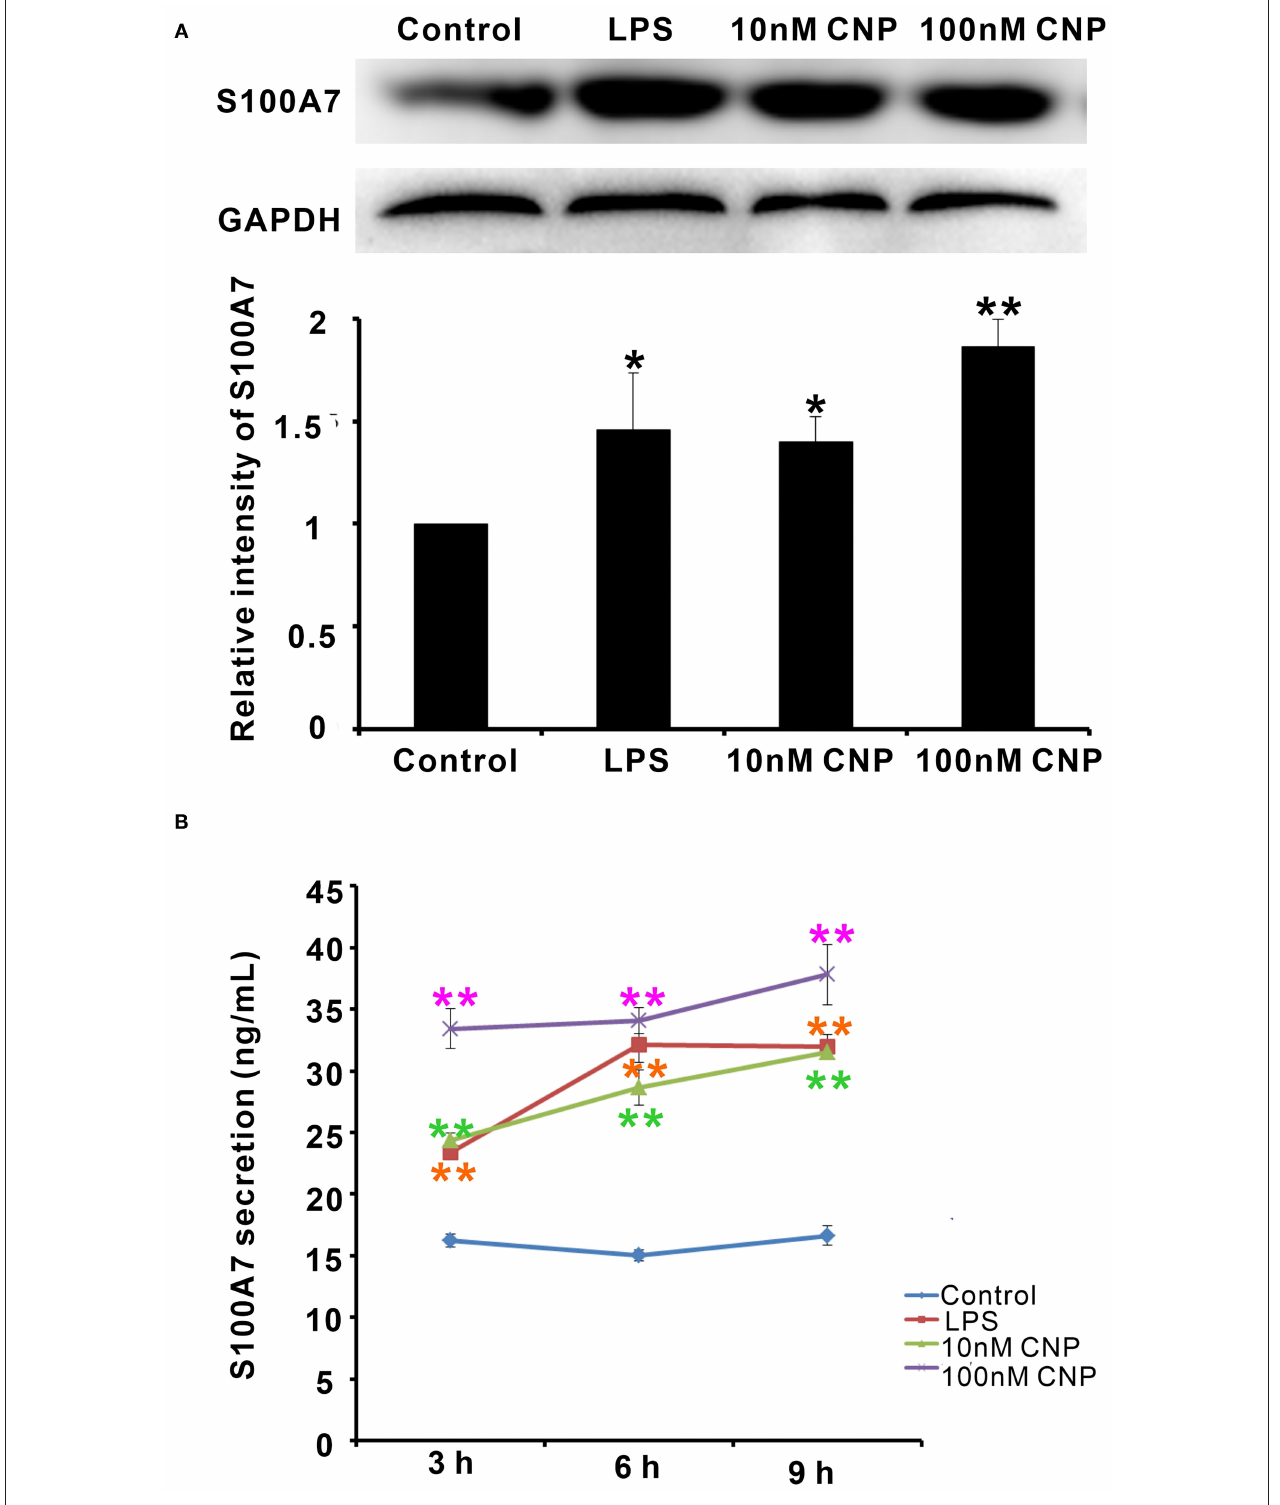
FIGURE 3 | CNP induced the expression and secretion of S100A7 in goat MECs. (A) Western blotting results showed the protein expression level of S100A7 in goat MECs after treatment by lipopolysaccharide (LPS), 10nM CNP, and 100nM CNP, respectively, for 6h. (B) ELISA results showed the S100A7 concentration in medium in which goat MECs were cultured and treated by LPS, 10nM CNP, and 100nM CNP, respectively, for 3, 6, and 9h. * p < 0.05 (compared to control); ** p < 0.01 (compared to control). Full-length blots are given in Supplementary Figures S6, S7 .